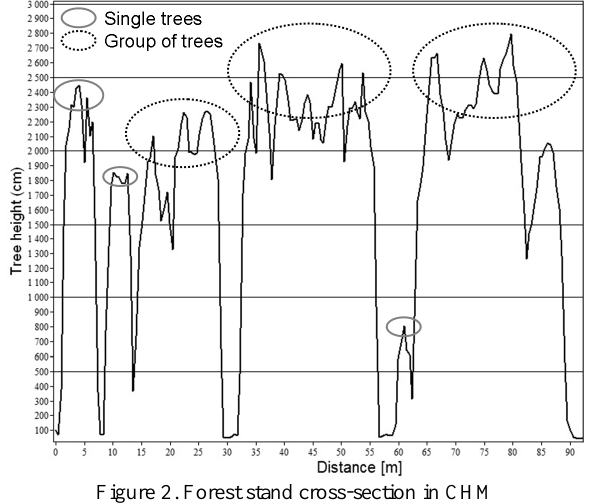
Figure 2. Forest stand cross-section in CHM